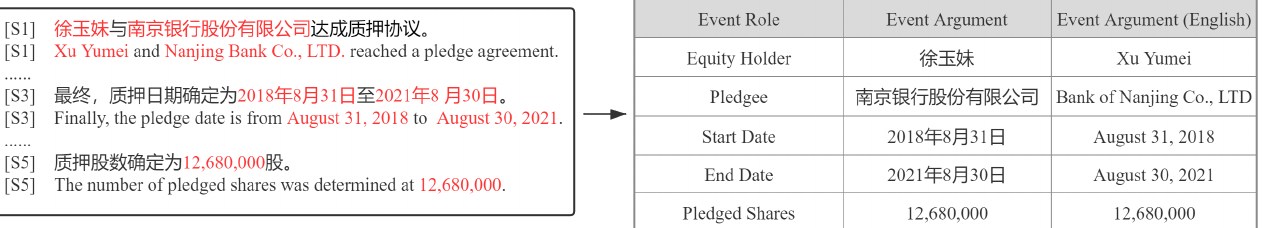
Figure 1. An example of event